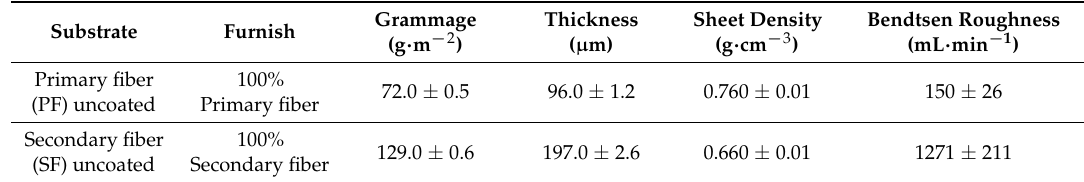
Table 1. Basic characterization of substrates used for barrier coating ( n =